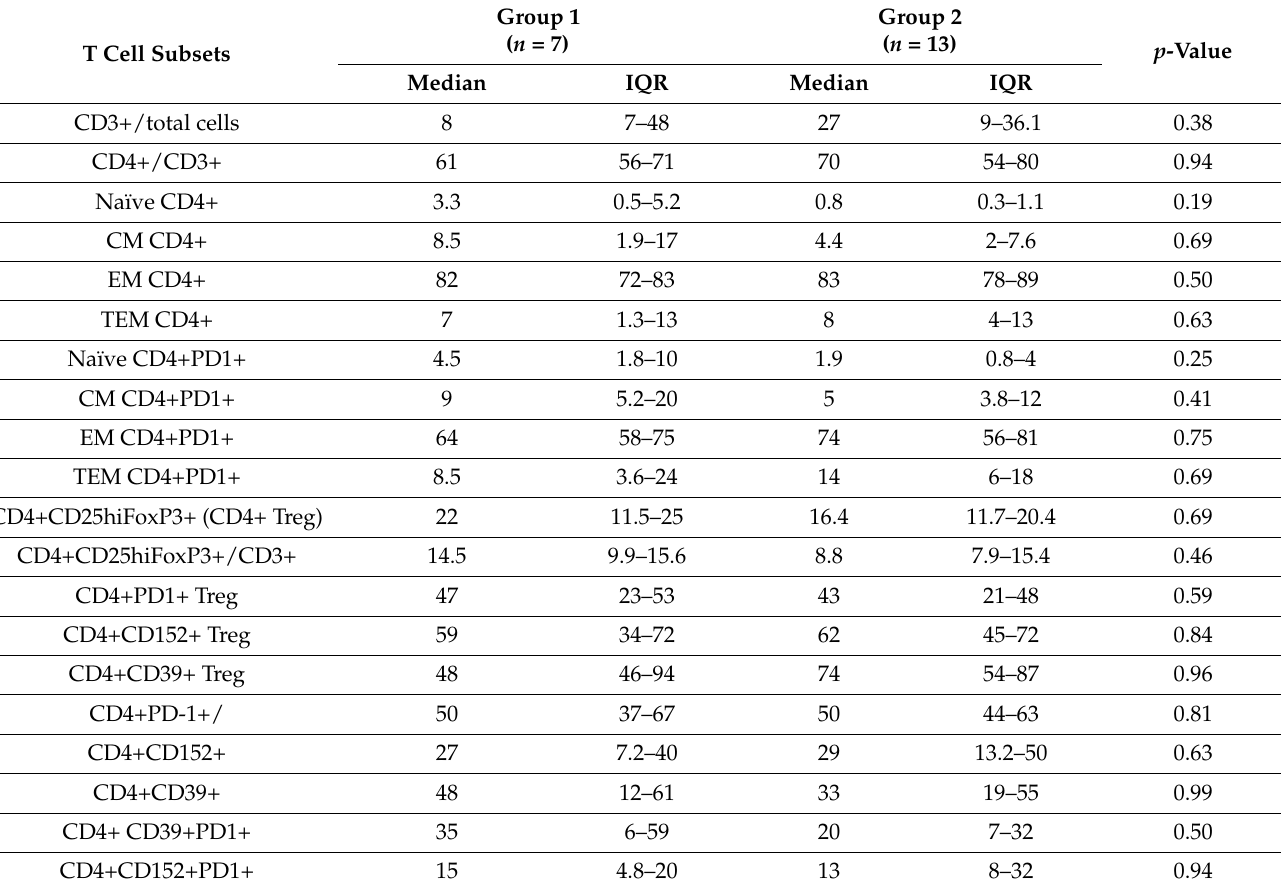
Table 2. Percent frequencies of HNSCC infiltrating CD3+ and CD4+ T cell subsets in Group 1 and Group 2.